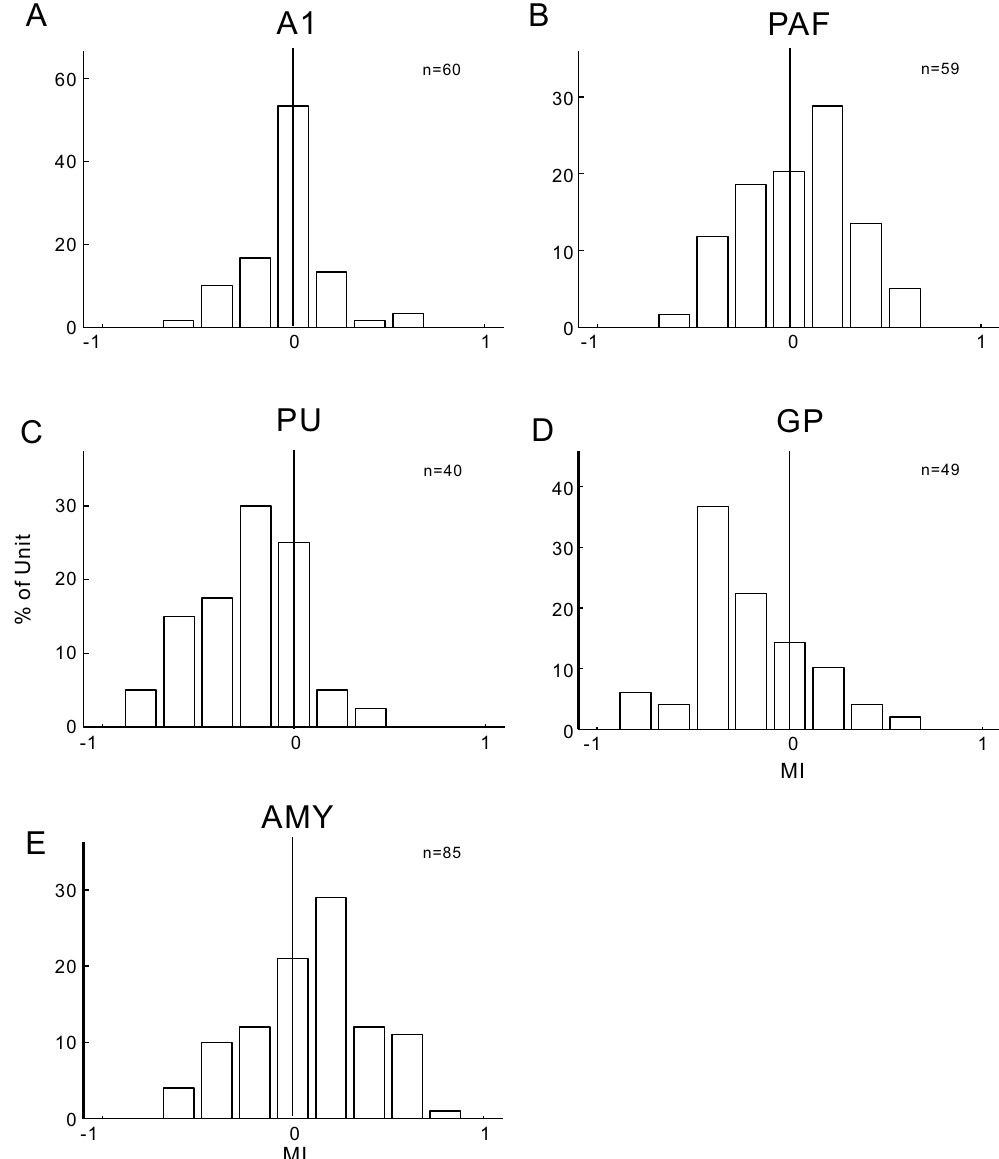
Figure 4. Distribution of the modulation index (MI) among the recorded units in different brain areas.